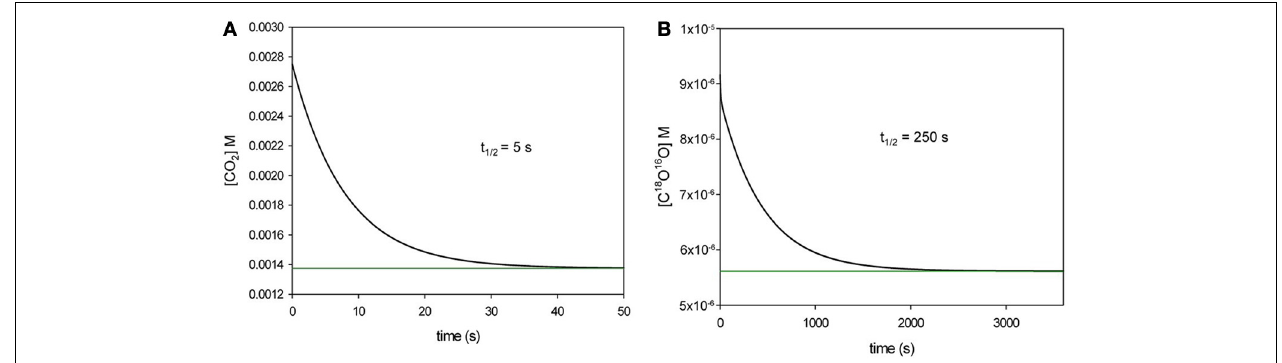
and HCO − 3 being in chemical equilibrium but not in isotopic equilibrium with water (B). Calculated for 37 ◦ C. Inserts indicate the half-times of the two